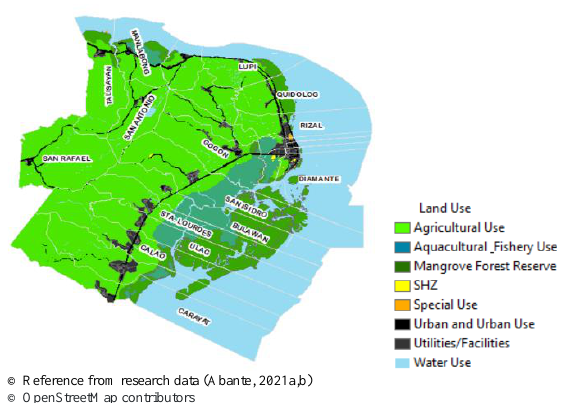
2.4.3 IEM-based land use supply analysis: Table 3 disclosed the matrix after carrying out an overlay analysis of subwatershed and ecosystem paired variables. U denotes the upland. M denotes the midland. L denotes the lowland. D denotes the coastal Figure 6 . Land and Water Use, 2021 dryland. W denotes the coastal wetland. Bi denotes the Bingay reefs. Mo denotes the Montufar